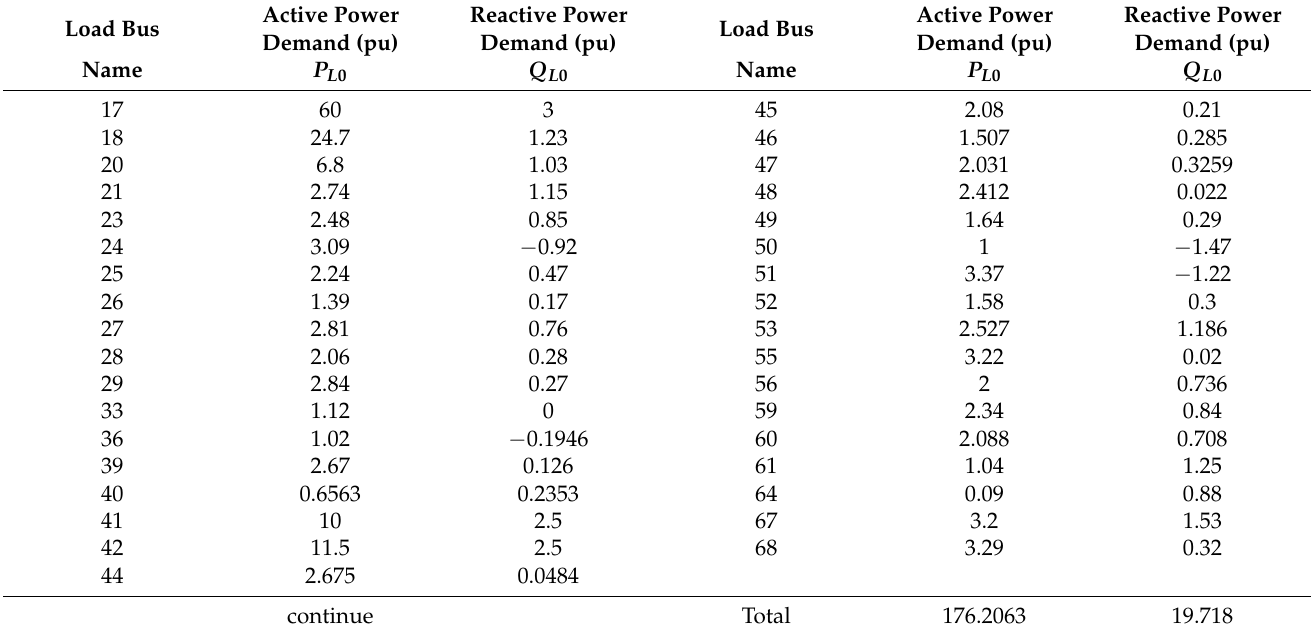
Table A2. Initial load bus data of the New England 68-bus test system for the